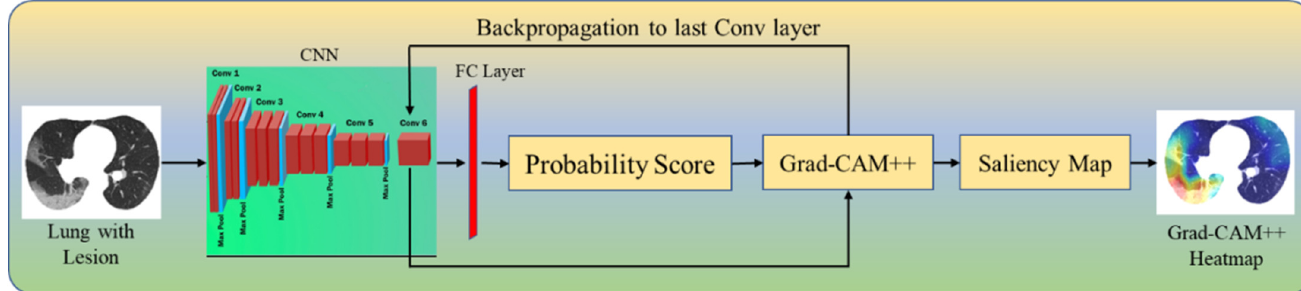
Figure 6. Grad-CAM++. Figure 6.